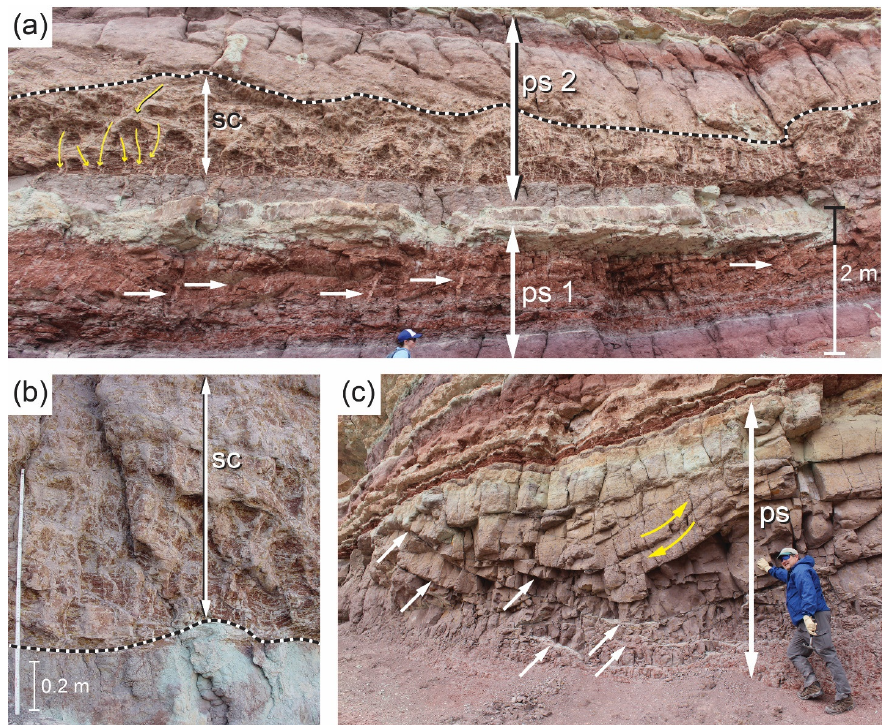
Figure 4. Photos illustrating paleo-Vertisol features in the Yellow Cat Member at Poison Strip, Utah (Figure 1; PS), where local conditions have maintained exceptional paleosol exposures of far greater quality than those at Utahraptor Ridge (Figure 3). ( a ) Two stacked paleosols (ps1, ps2); ps1 contains several carbonate-filled cracks (horizontal white arrows), and ps2 exhibits a zone of prominent, filled soil cracks (sc). Pathways of the downward translocation of sandier soil material from above into clayey soil material below are shown for selected cracks as yellow arrows at the left. ( b ) Closeup of soil cracks (sc) in ps2. ( c ) Another paleosol (ps) with prominent slickensides, identified by diagonal white arrows; general sense of shear along slickensides is shown by yellow arrows. Shear within this Early Cretaceous soil profile moved materials obliquely up and down. Features shown in these photographs suggest that perfect stratigraphic superposition (e.g., of paleosol organic matter and volcanogenic zircons) is very unlikely to exist within these paleosol profiles due to ancient pedoturbation. We propose that conditions were similar at Utahraptor Ridge during the Early Cretaceous (see text for further discussion).